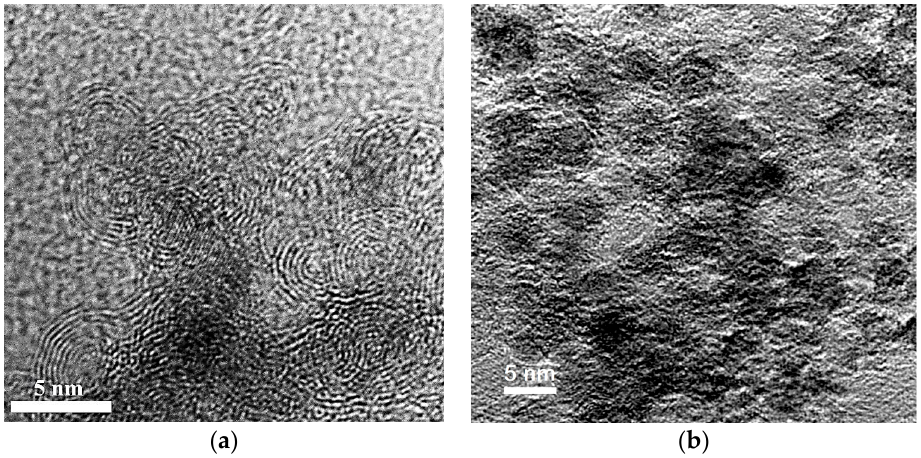
Figure 5. TEM images of the nanodiamonds material: ( a ) carbon onions; and ( b ) nanodiamonds.